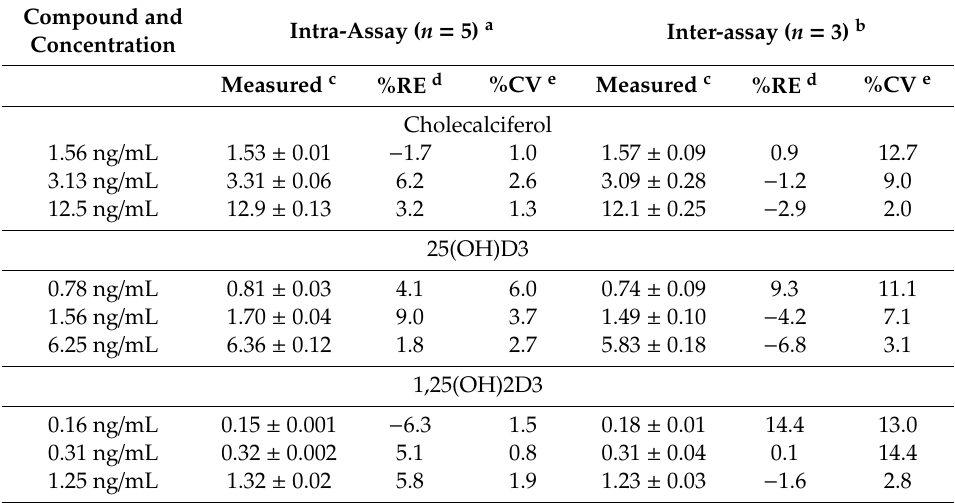
Table 3. Precision and accuracy of cholecalciferol, 25(OH)D3 and 1,25(OH)2D3 measurements. Compound and Concentration